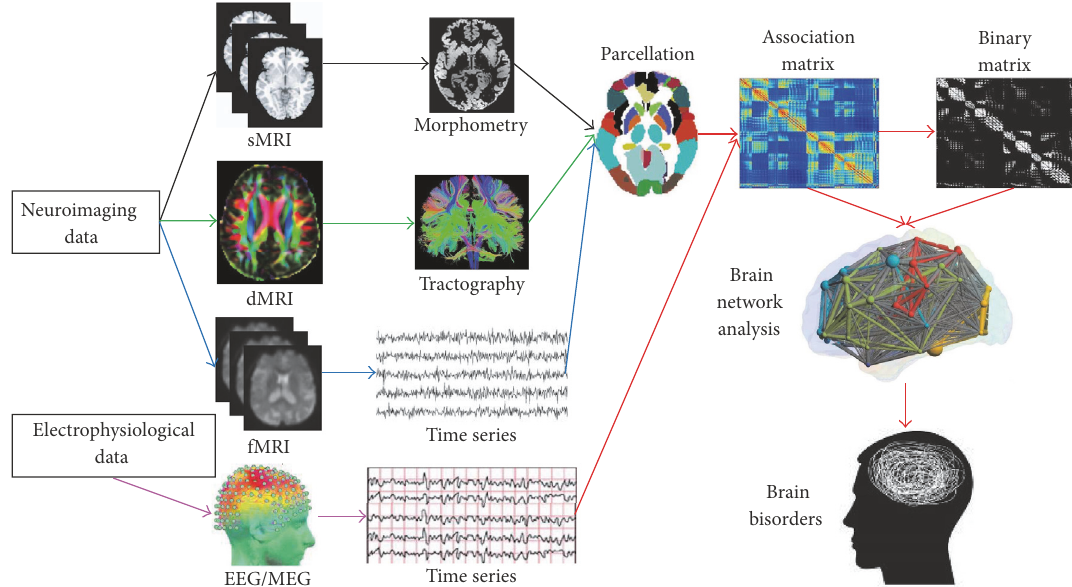
Figure 1: A general perspective for complex brain network analysis methods and its applications in brain